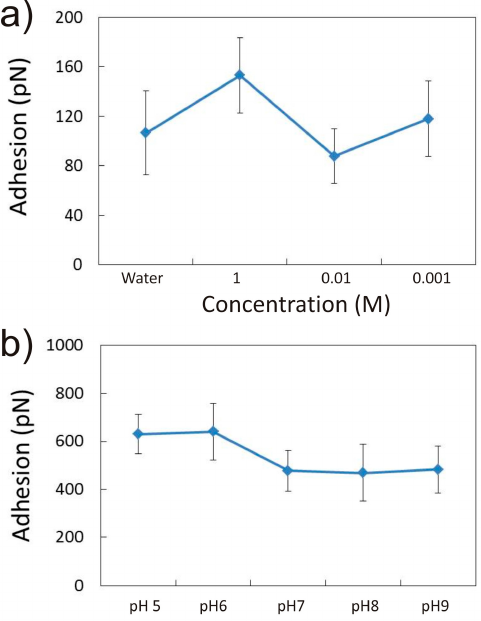
Figure 7. ( a ) Graph showing the role of NaCl concentration in modifying the measured adhesion of a –COOH functionalised prove over the kaolinite siloxane surface (kao-Si-7); ( b ) graph showing the effect of pH on the measured adhesion of –COOH groups to a kaolinite siloxane surface in the presence of 0.001 M NaCl solution (kao-Si-8).